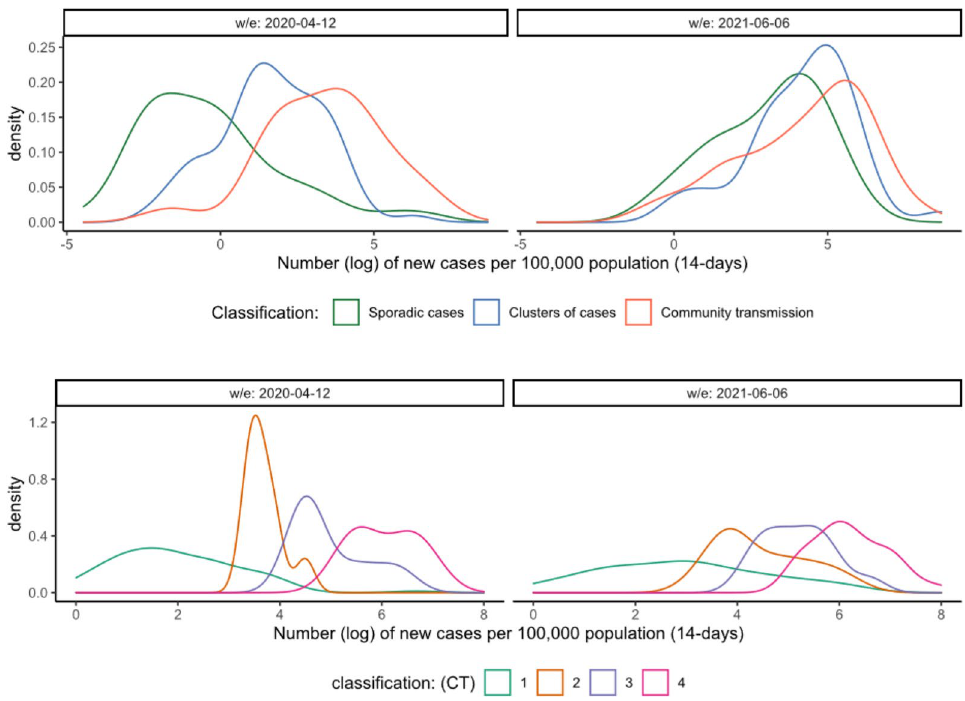
Figure 1. Density of weekly incidence rate per 100,000 population (14 days average) in each transmission class. Top row: following classification guidance published in March 2020. Bottom row: following classification guidance published in November 2020 and the median of scores as the aggregate approach. The overlap between the different categories (top right) illustrates the inconsistencies in the initial classification (i.e., countries reported similar number of new cases but different categories). The bottom row shows distinctive grouping of the data around each category indicating a consistent classification through time. The complete distribution series can be found in the supplementary material.